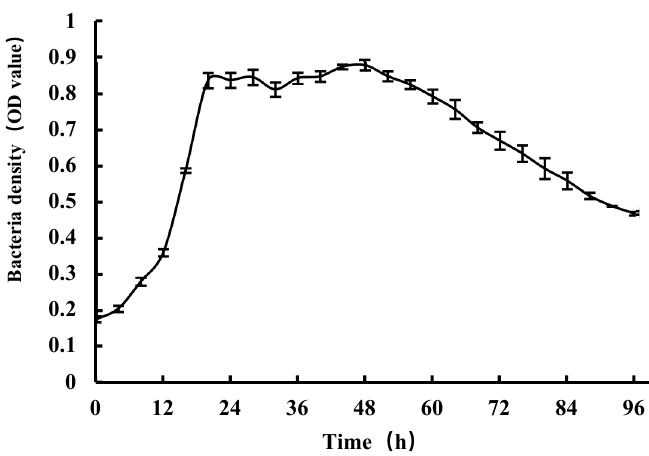
Figure 1. The growth curve of magnetotactic bacteria AMB-1.